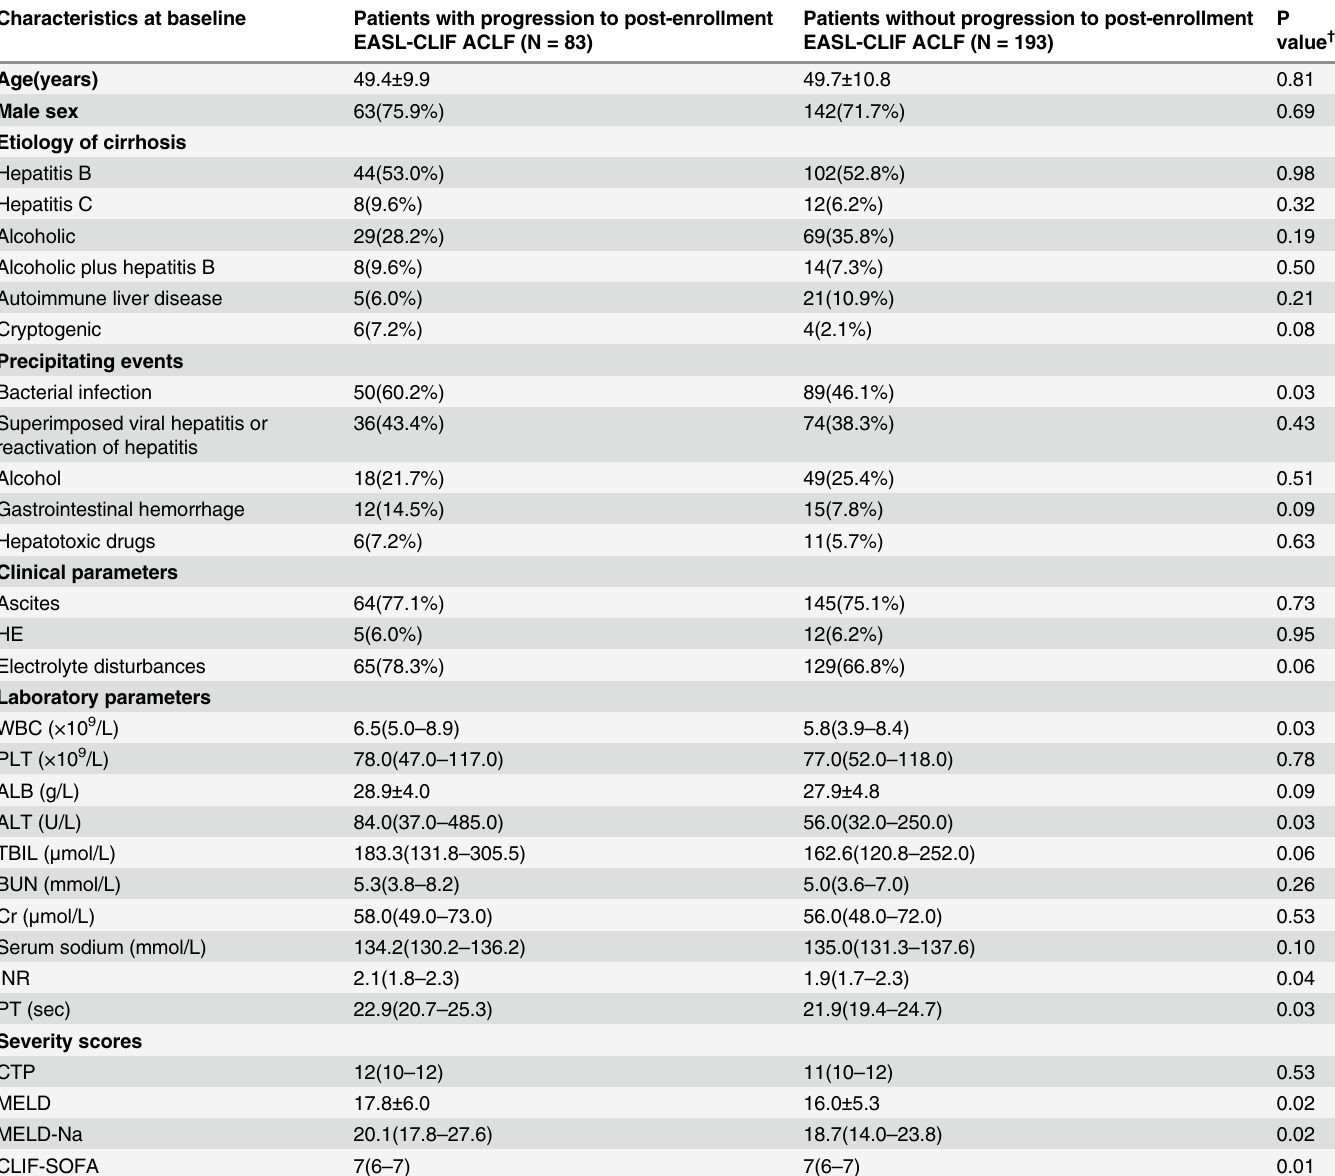
Table 2. Comparison of baseline characteristics between patients with and without progression to post-enrollment EASL-CLIF ACLF. Characteristics at